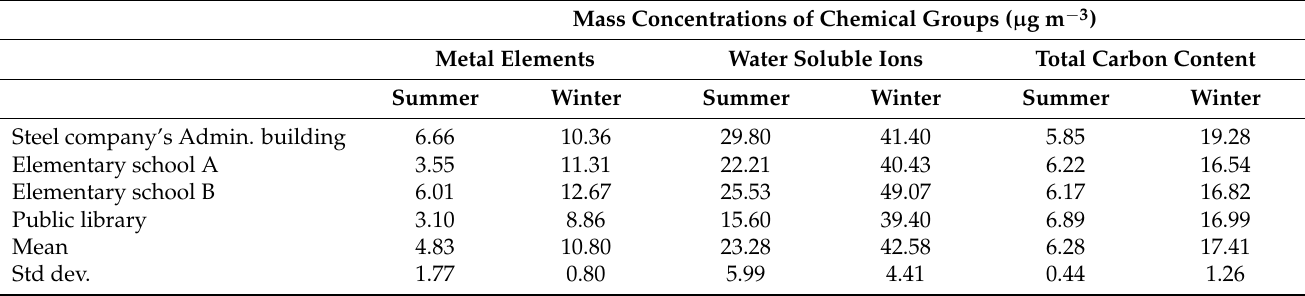
Table 2. Seasonal concentrations of metal elements, water soluble ions, and total carbon